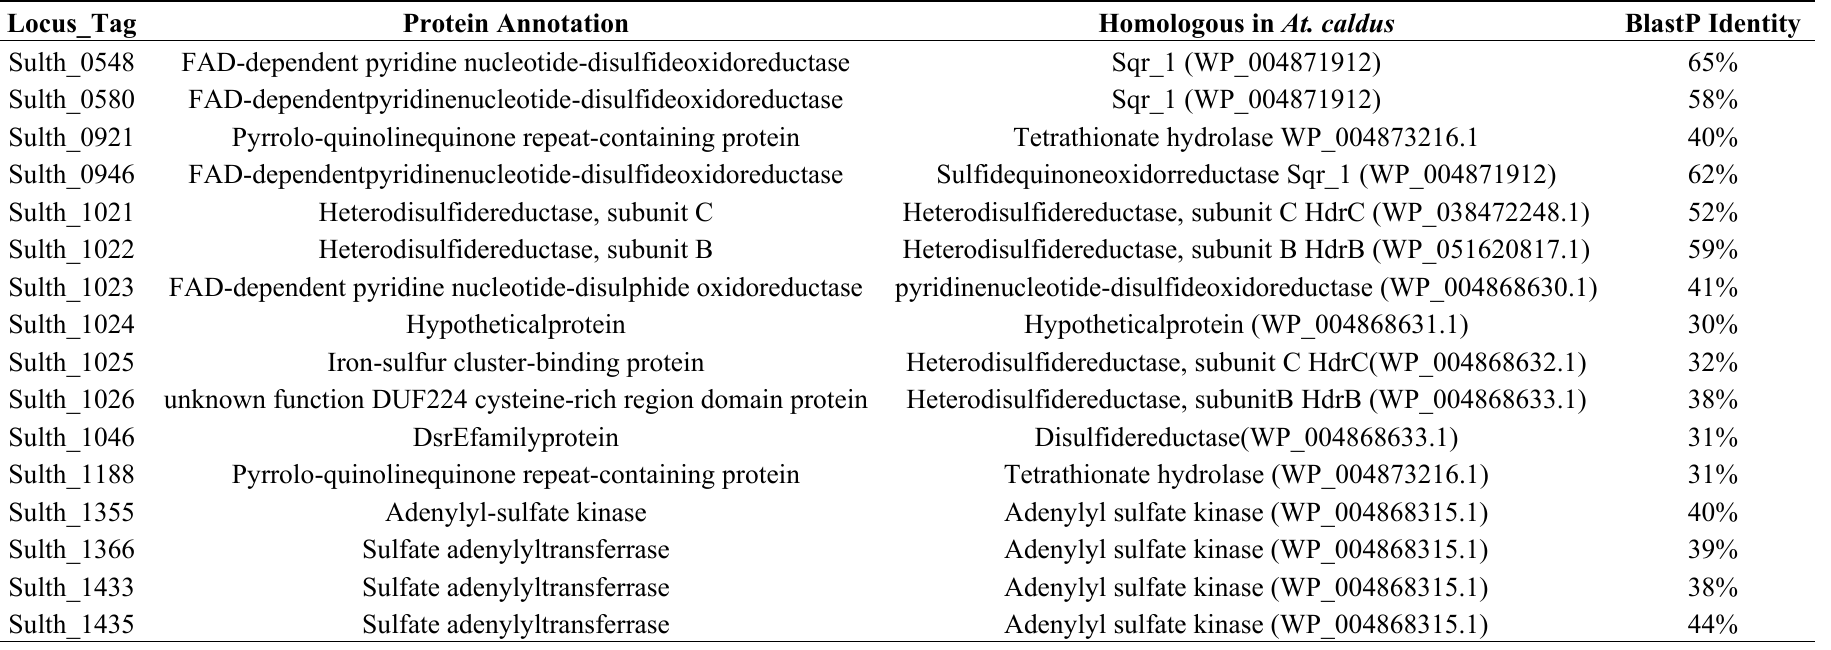
Table 2. Proteins related to sulfur metabolism encoded in Sb. thermosulfidooxidans